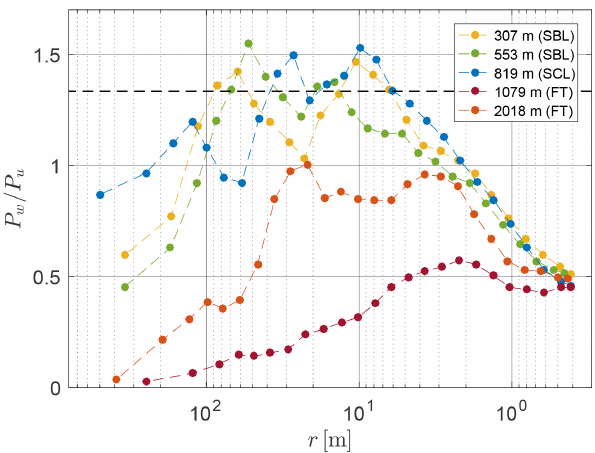
Figure 17. Spectral anisotropy ratio in the coupled STBL (flight no. 5). The horizontal dashed line denotes the 4 / 3 level expected for isotropy in the inertial range.